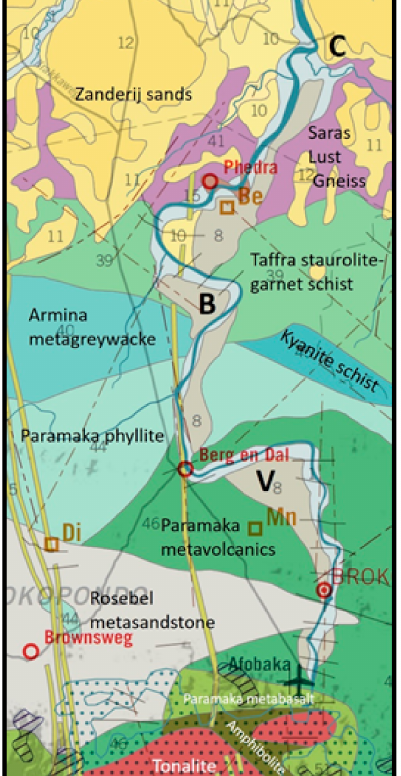
Figure 7. Geological map with Zanderij Formation indicated in yellow. Other colors represent basement rocks (V = Victoria; B = Baboenhol; C =